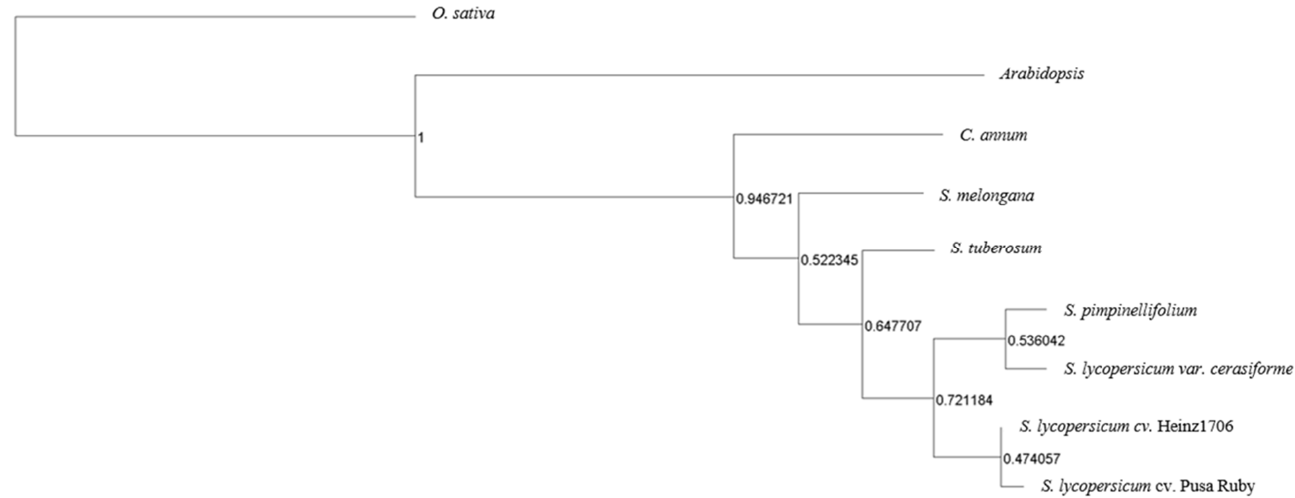
Figure 5. Phylogenetic tree depicting relationship between S. lycopersicum cv. Pusa Ruby and related Solanaceae species based on orthologous groups, and with rice and Arabidopsis as outgroups. The tree was generated using Orthofinder [51] 3.6 Allele mining of genes involved in Regeneration